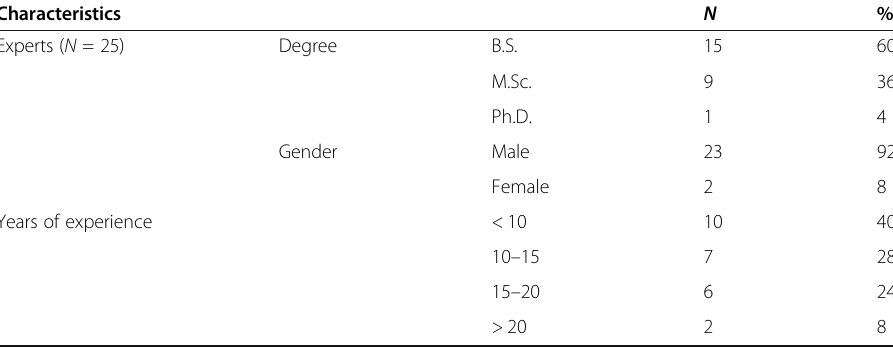
Table 2 The demographic characteristics of chosen experts Characteristics